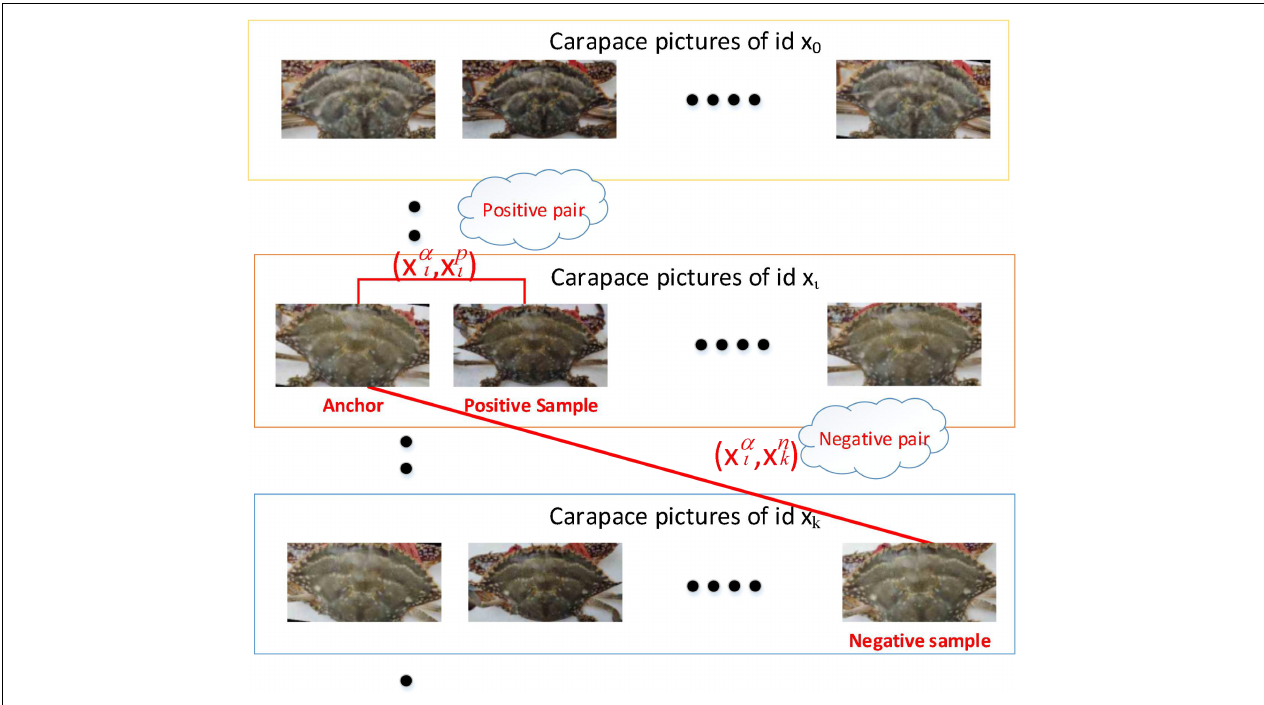
FIGURE 7 | Example of triplet loss, where the lines represent the positive sample pair and the negative sample pair. The similarity is measured by Euclidean distance.